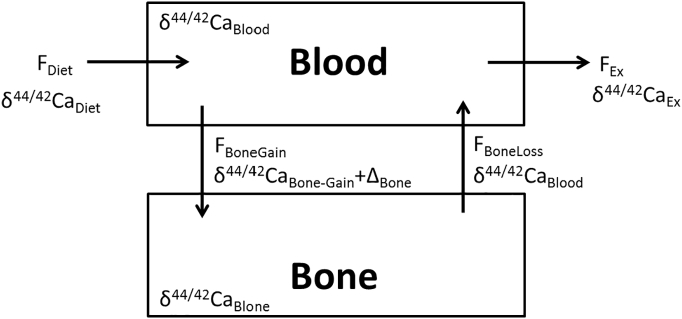
Simplified transport model for Ca isotopes between blood and bones in humans. In this model, there is no calcium isotopic fractionation associated with absorption, excretion of dietary calcium and dissolution of bones. Calcium incorporated into bone is derived from the blood, and there is a fractionation (ΔBone) associated with the formation of bones.